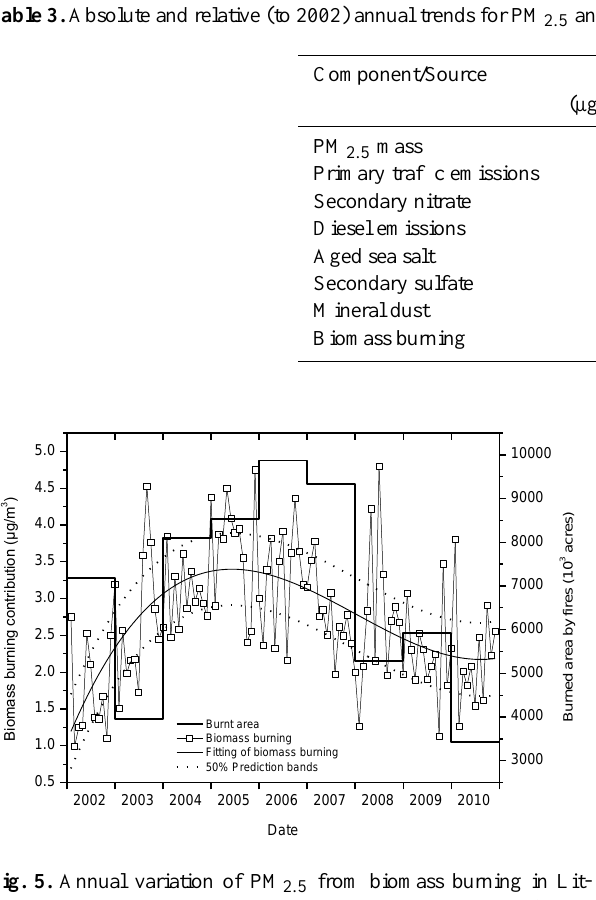
Table 3. Absolute and relative (to 2002) annual trends for PM 2 . 5 and source contributions in Little Rock, Arkansas.